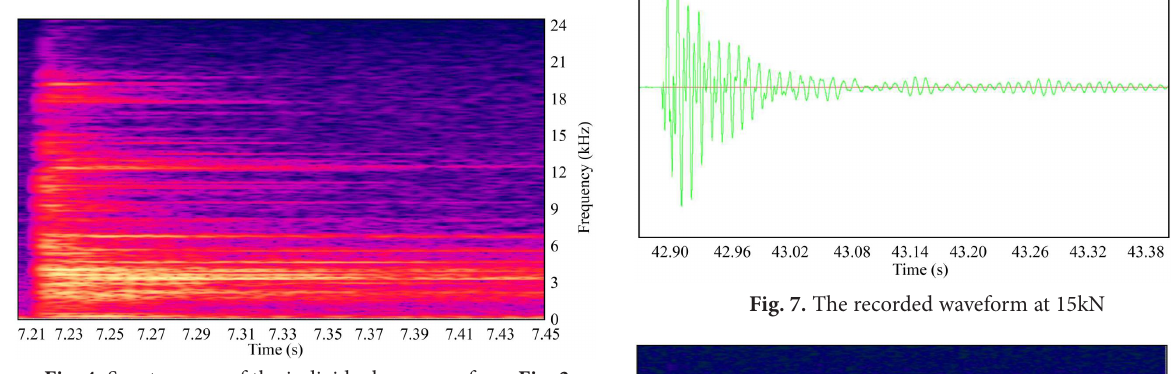
Fig. 4. Spectrogram of the individual response from Fig. 3